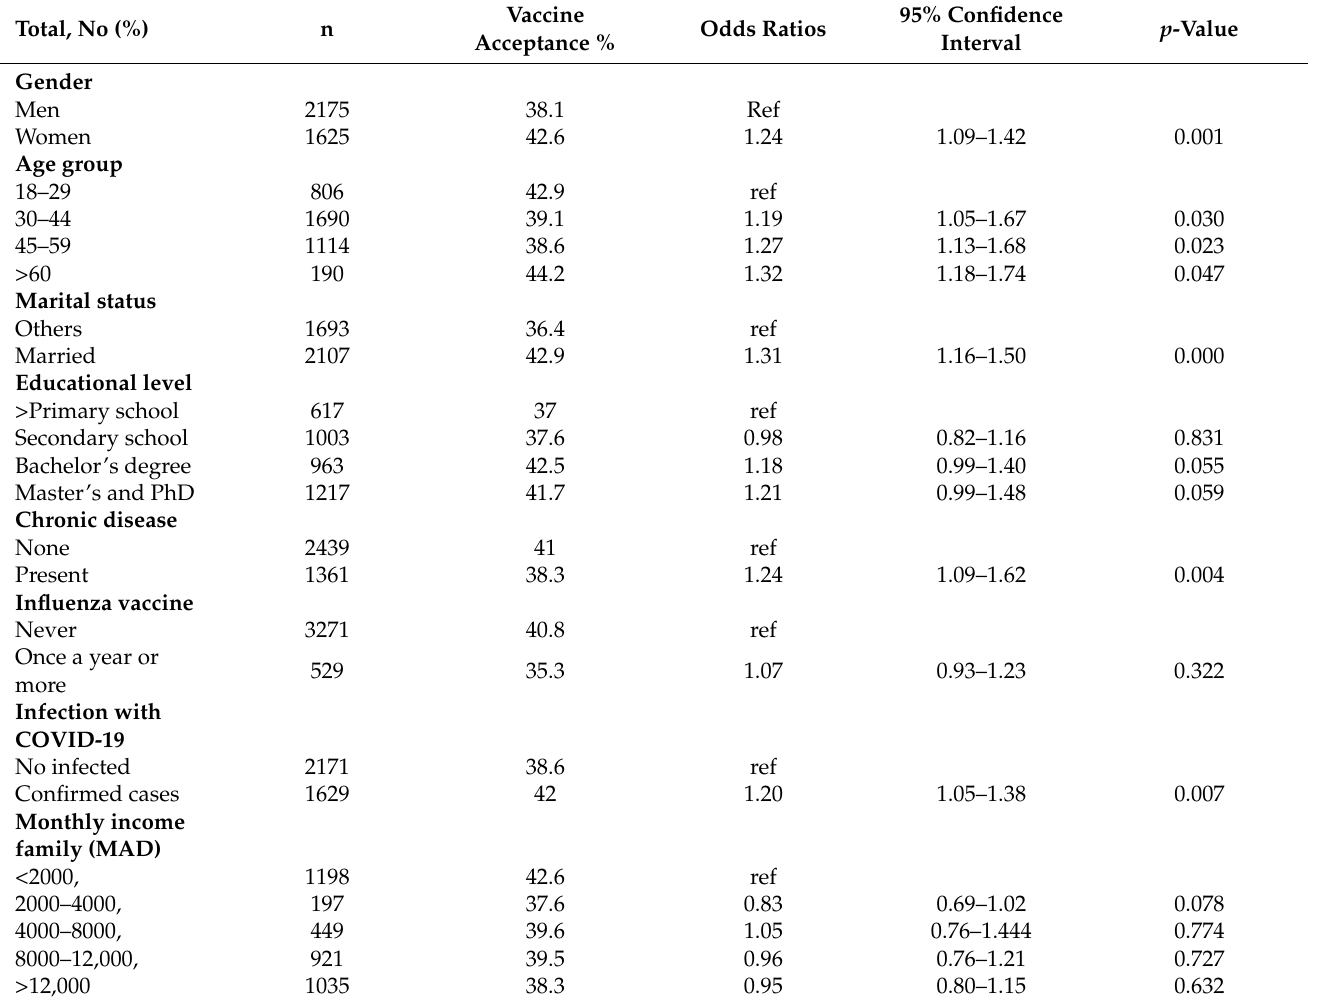
Table 2. Factors associated with acceptance of COVID-19 vaccine by binary logistic